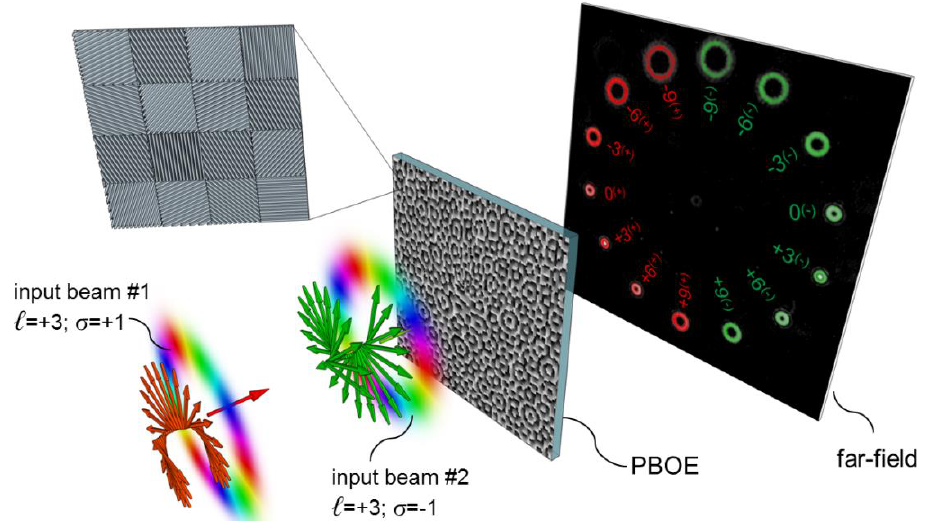
Figure 1. Scheme of the Pancharatnam–Berry optics working principle for an orbital angular momentum (OAM) beam sorting with the method of optical beam projection. When a circularly polarized OAM beam illuminates the optical element, a bright spot appears in the far field at a position depending on the carried OAM and on the polarization handedness. In the presented work, the Pancharatnam–Berry optical element (PBOE) is implemented in the form of a pixelated metasurface of rotated subwavelength grating.